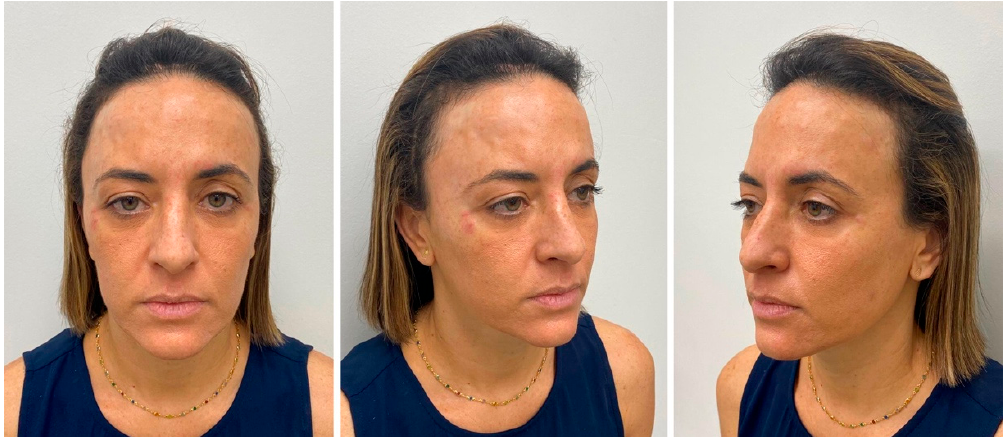
Figure 10. Immediate result after the second application.